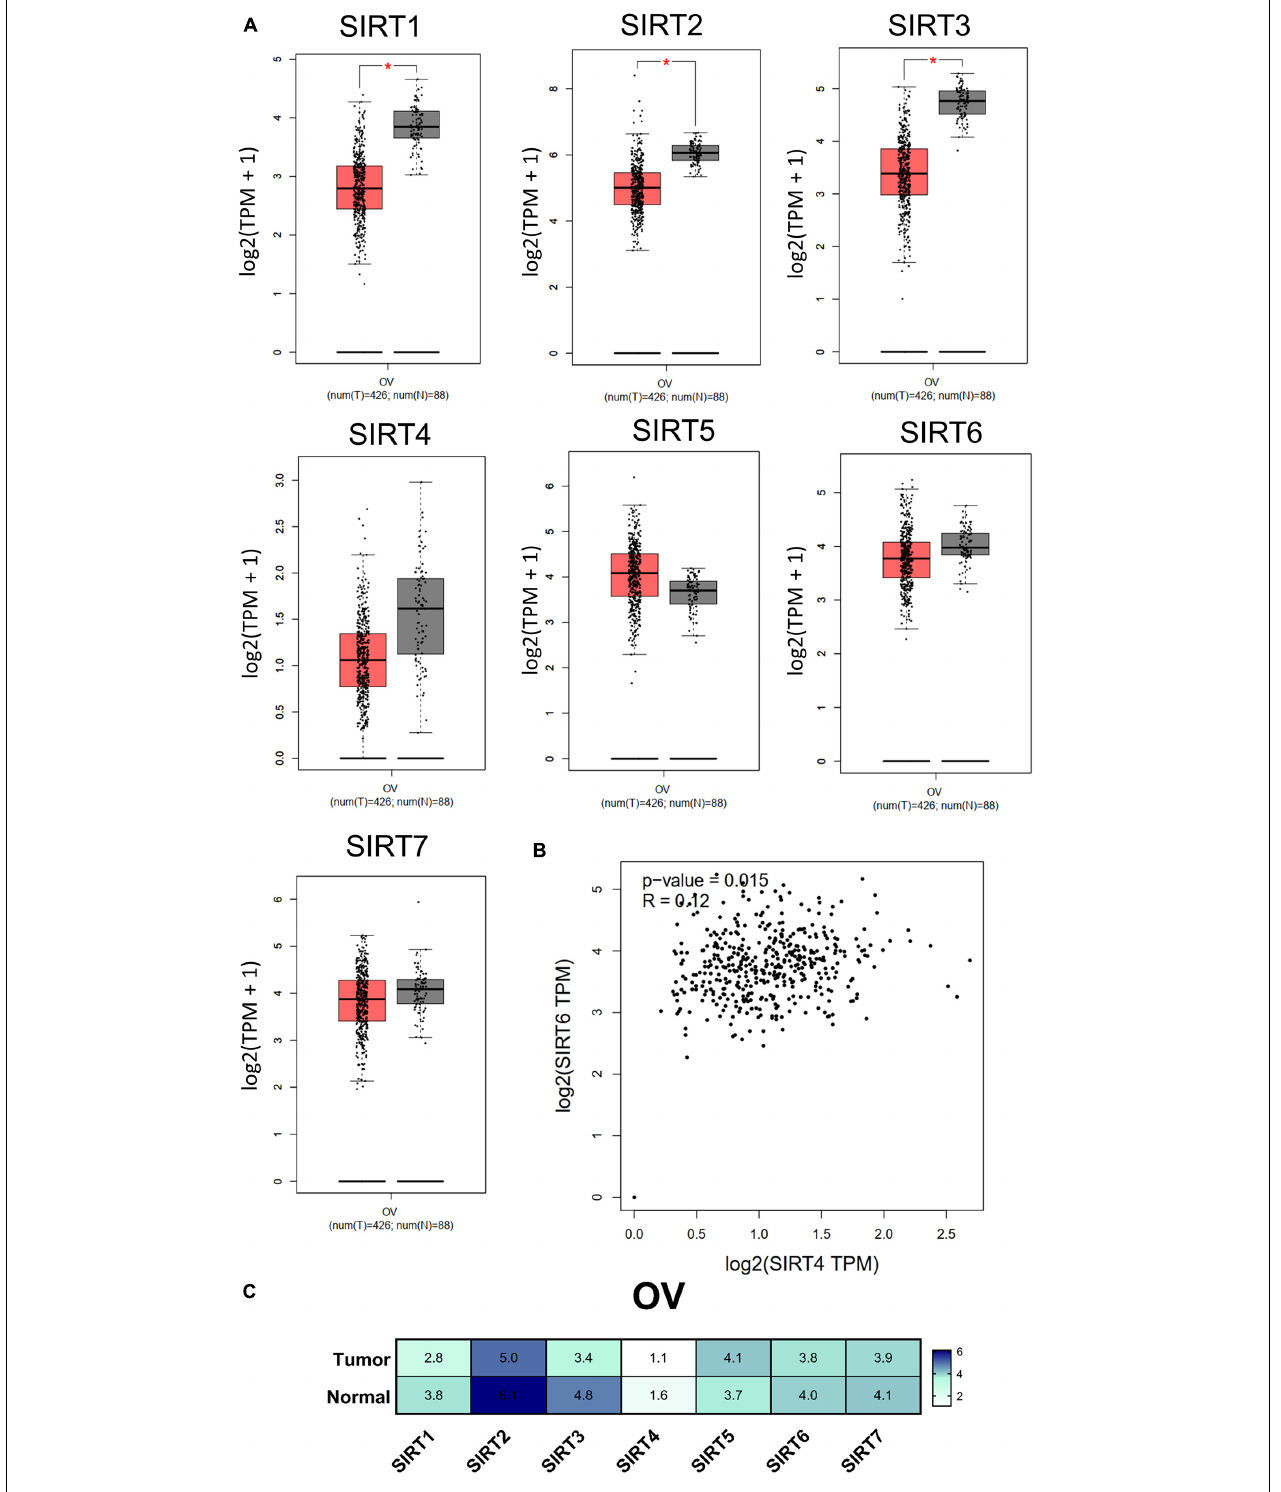
FIGURE 3 | Differential expressions of the sirtuin family members in ovarian cancer and normal ovarian tissues. (A) Comparison of normalized sirtuin family member expression levels in tumor samples vs . those in normal tissues. The cancer abbreviation name is shown according to The Cancer Genome Atlas (TCGA) study abbreviation ( OV , ovarian cancer). * p < 0.05 was considered statistically significant. (B) Dot plot of SIRT4 and SIRT6 correlations calculated by Pearson’s correlation test from TCGA-OV. (C) Heatmap of the expressions of the sirtuin family members by log 2 (TPM + 1) for log-scale ( number in the cell ).